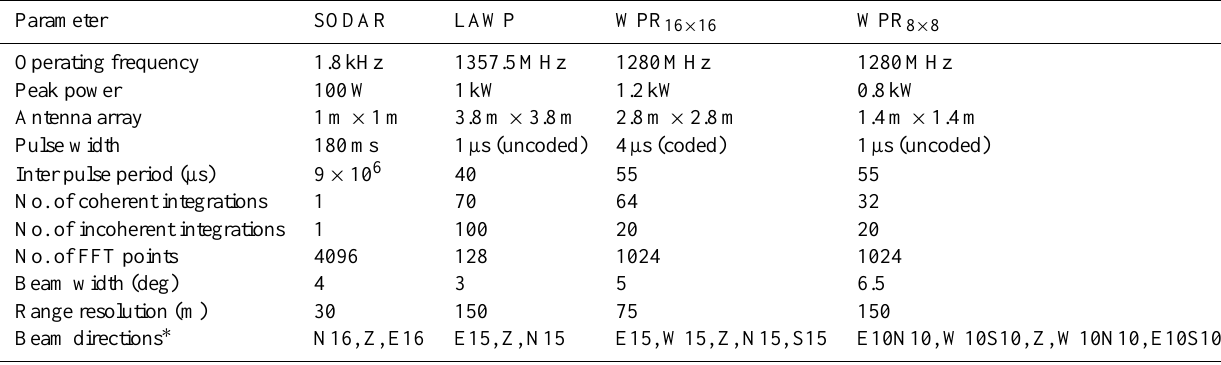
Table 3. Major specifications of SODAR, LAWP, WPR 8 × 8 and WPR 16 × 16 .